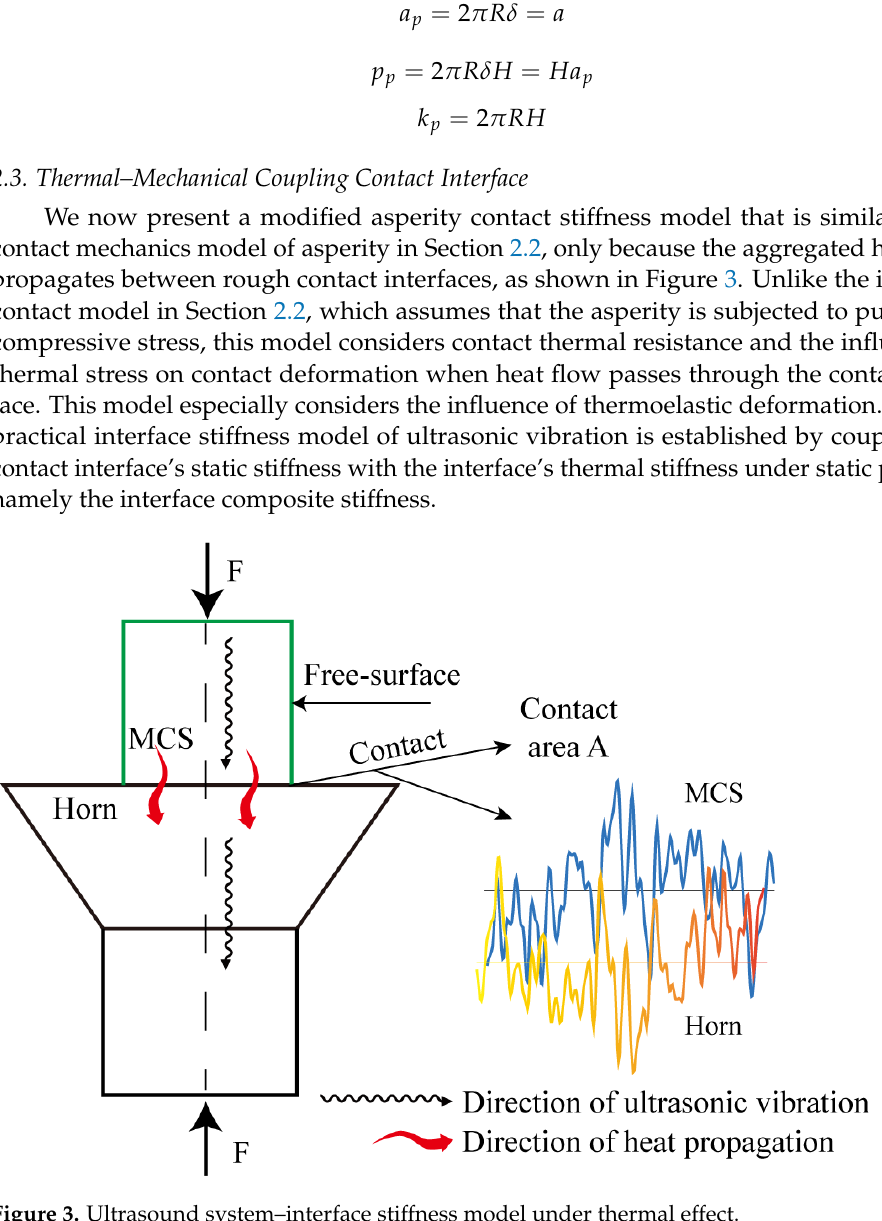
Figure 3. Ultrasound system–interface stiffness model under thermal effect.